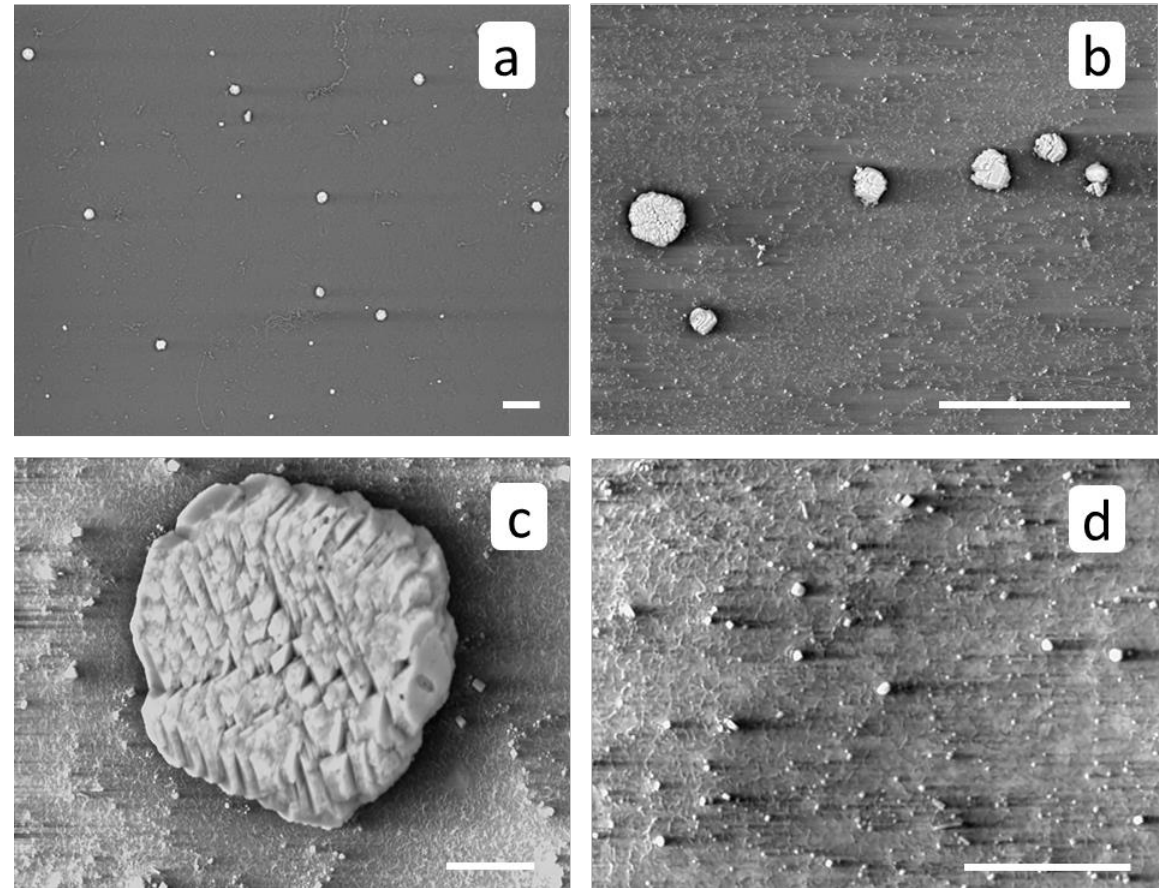
Figure 6. SEM images of RO membrane surface after a blank run. Scale marker corresponds to 100 μm ( a , b ) or to 10 μm ( c , d ).